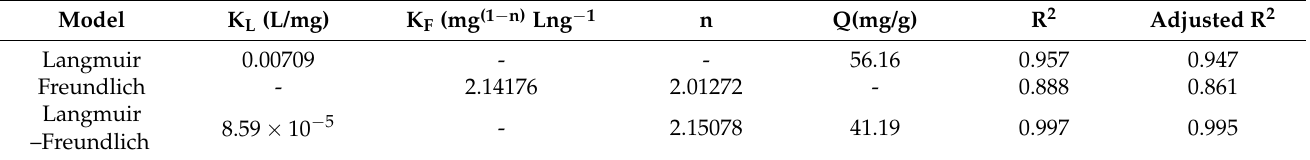
Figure 7. adsorption isotherm for Phosphate on MBK. Table 3. MBK phosphate adsorption isotherm